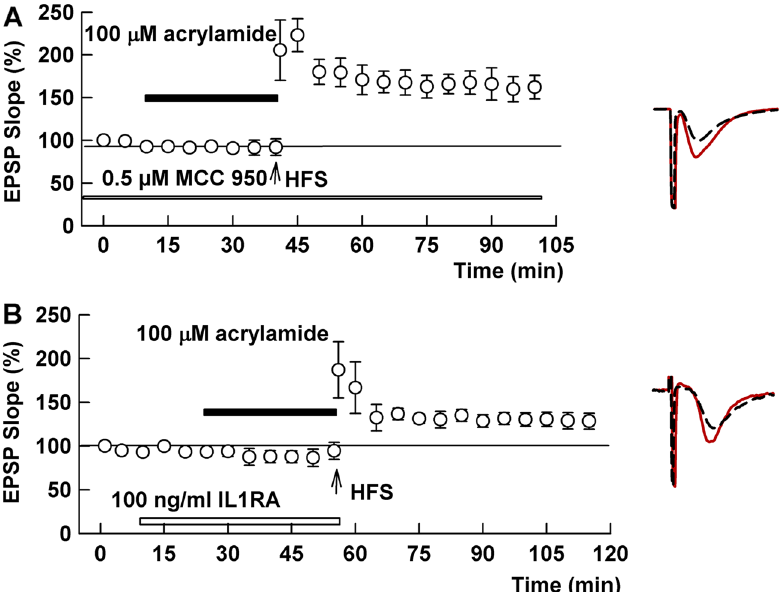
Figure 5. An NLRP3 inhibitor and IL-1 receptor antagonist overcome effects of ACR on LTP. ( A ) Prolonged administration of 0.5 μM MCC950, an inhibitor of NLRP3 for 2–4 h (white bar) prior to HFS (arrow) allows LTP induction in spite of the presence of 100 µM ACR (black bar). ( B ) Similarly, in the presence of 100 ng/ml Interleukin-1 receptor antagonist (white bar), ACR fails to block LTP induction. Traces show representative EPSPs. Calibration: 1 mV, 5 ms.